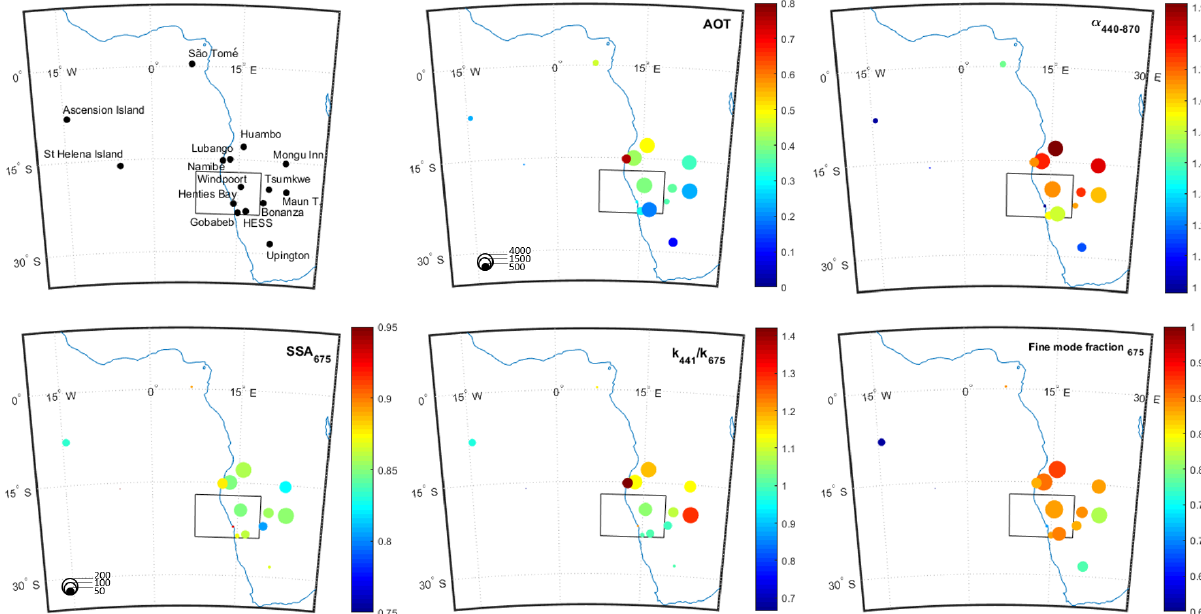
Figure 4. Mean values of AOD at 550nm, α 440 − 870 , SSA at 675nm, ratio of the imaginary part of the refractive index ( k ) between 441 and 675nm, and the fine- to coarse-mode fraction of the aerosol volume concentration from 15 AERONET sites in the southeastern Atlantic region. The selected period is from 15 August to 15 September 2017. The black box corresponds to the AEROCLO-sA flight domain. Circle size is linked to the availability of the data in the number of measurements.